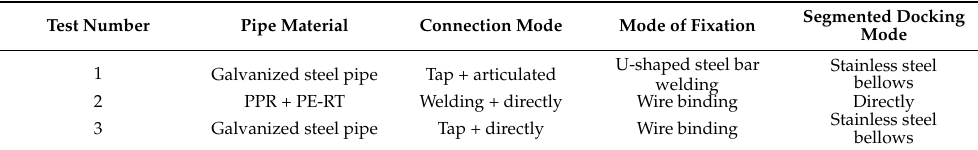
Table 3. Pipeline layout